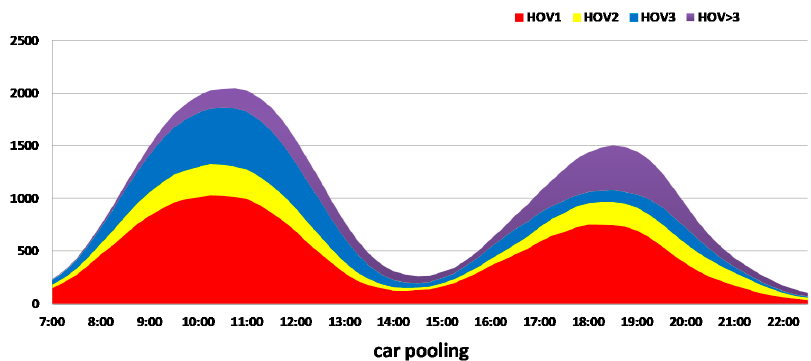
Figure 12. The change over time: the number of cars and passengers, for the reference variation and for the “patient agents, the price is decreasing exponentially” variation.